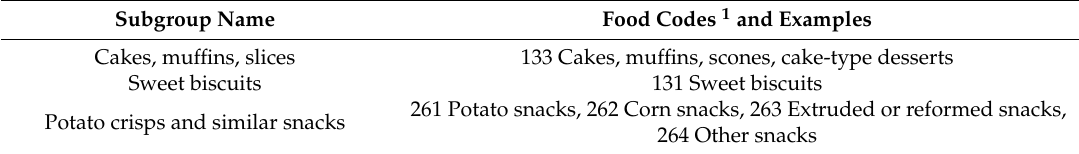
Table A1. Discretionary subgroup classifications using the Australian Bureau of Statistics Food